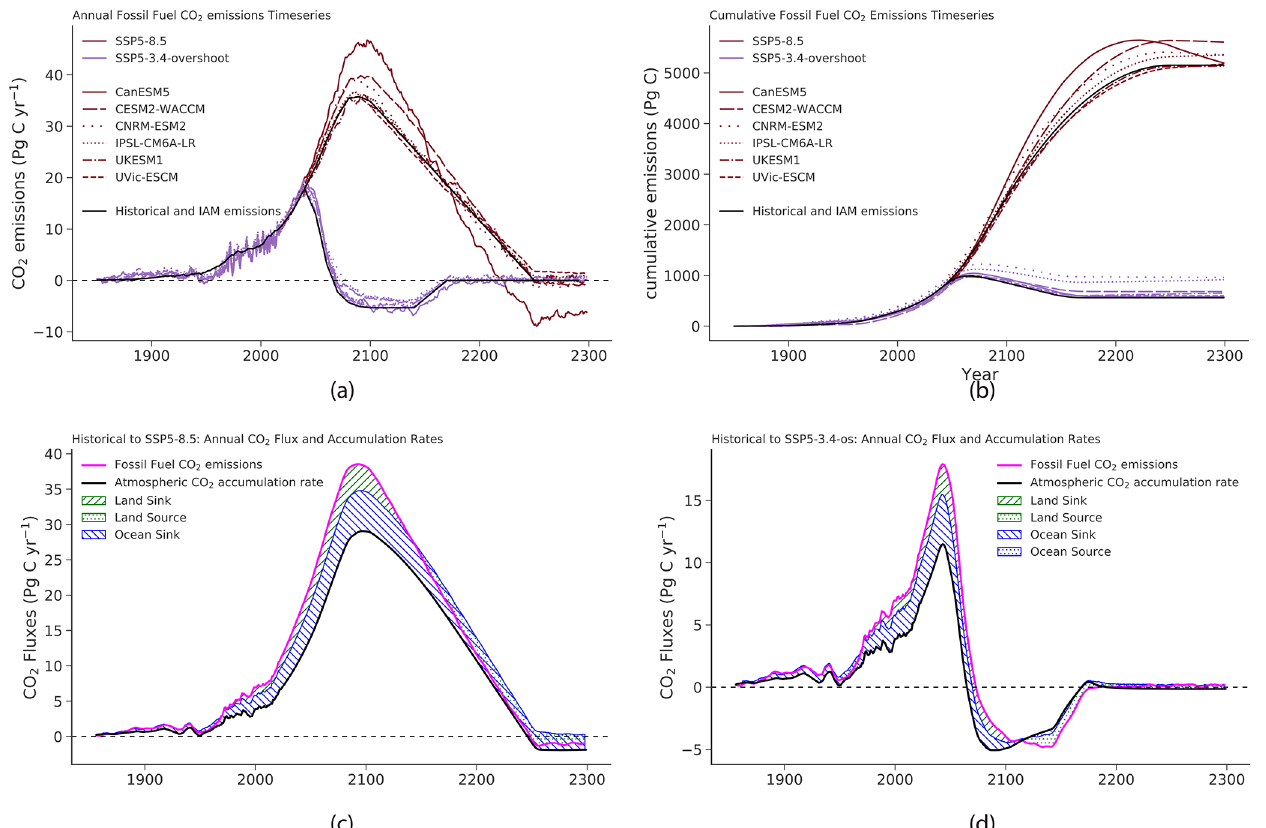
Figure 2. (a) ESM-inferred and IAM-specified harmonized annual fossil fuel (positive) and geologically sequestered (negative) CO 2 emis- sions. (b) Cumulative fossil fuel (positive) and sequestration emissions (negative) as inferred by each ESM. (c, d) Ensemble mean land, ocean, and fossil fuel emission fluxes shown together for the historical and future (c) SSP5-8.5 and (d) SSP5-3.4-overshoot scenarios. In (c, d) , pink curves represent the annual fossil fuel CO 2 emissions. Land and ocean sink fluxes are represented as hatched area, and source fluxes are represented as stippled area. The atmospheric CO 2 accumulation, which is the sum of fossil fuel, land, and ocean fluxes, is shown as the black